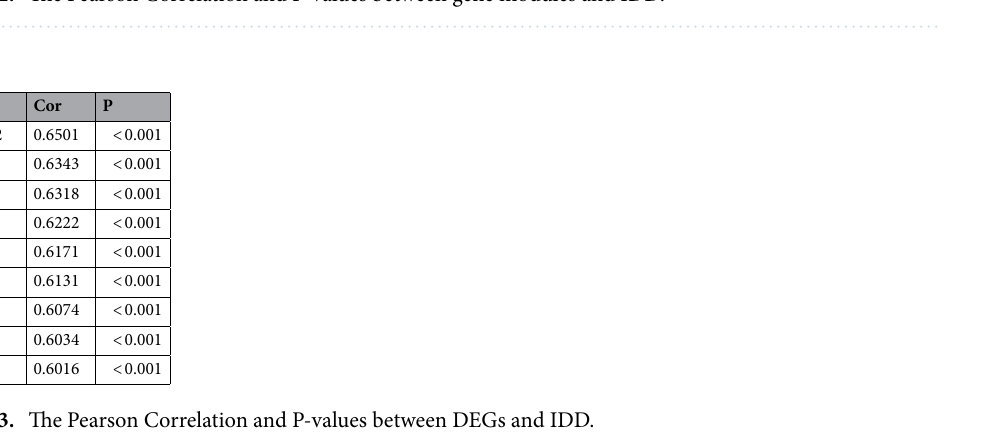
Table 3. The Pearson Correlation and P-values between DEGs and